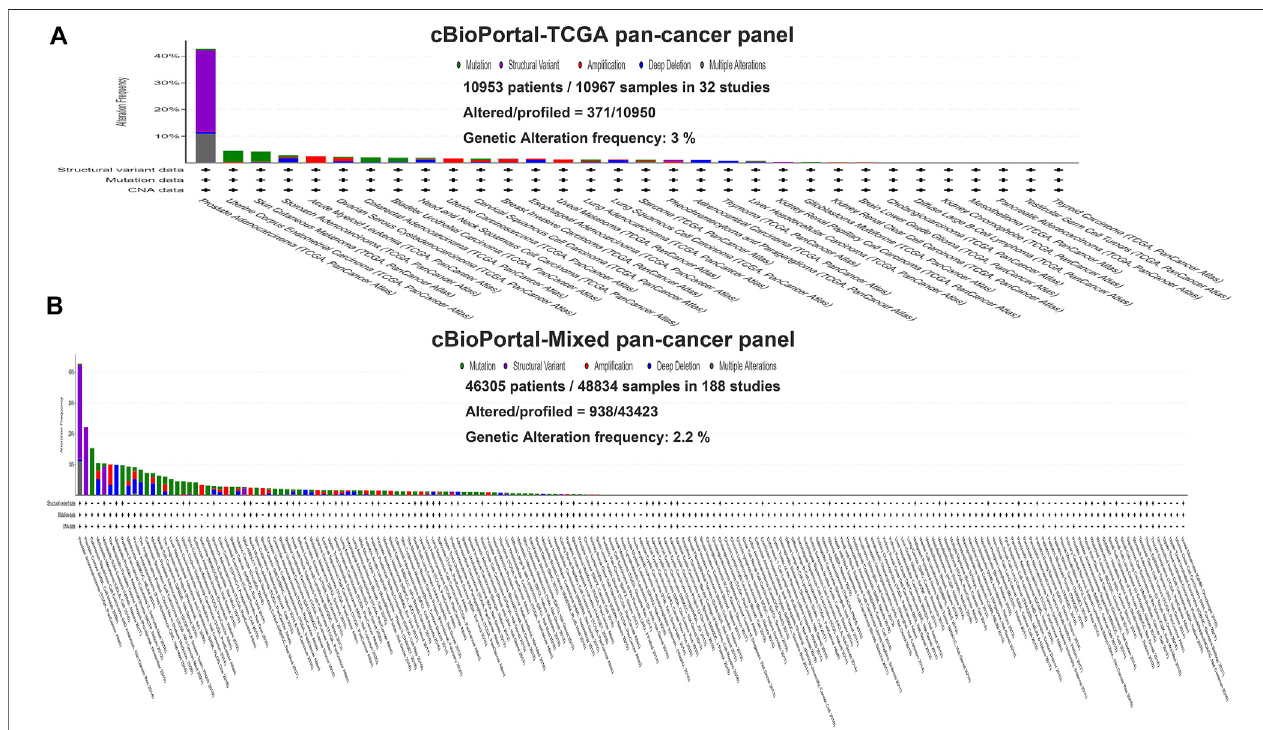
FIGURE1| Genetic variation ofTMPRSS2 intumors. (A) TheTCGA pan-cancerpanel wasobtained from thecBioPortal dataset, whichincluded 10,953 patients/ 10967 samples in 32 studies. (B) The mixed pan-cancer panel was obtained from the cBioPortal dataset, which also included 46,305 patients/48,834 samples in 188